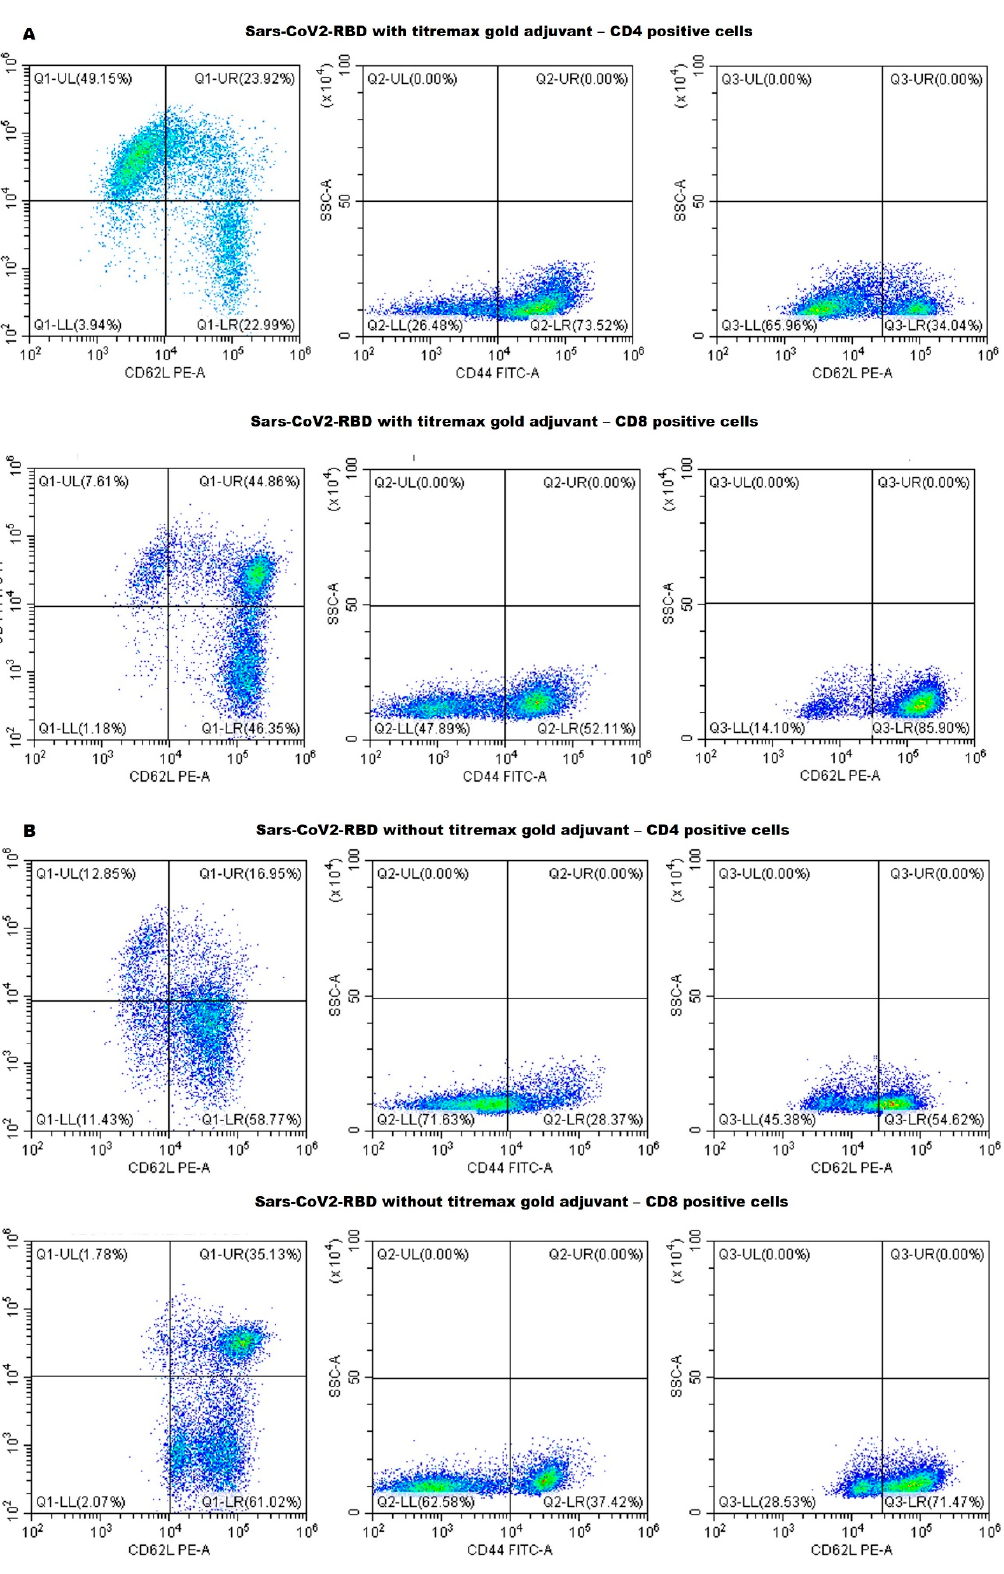
Figure 5. Flow cytometry analysis of cell surface CD (cluster of differentiation) markers. A single-cell suspension of mouse splenocytes in FACS buffer was used for flow-cytometry analysis. Differential expressions of cell surface CD markers induced by T-helper cell (CD4+) and T-cytolytic cell (CD8+) with ( A ) and without ( B ) an adjuvant group. The figure represents data from a single mouse from each